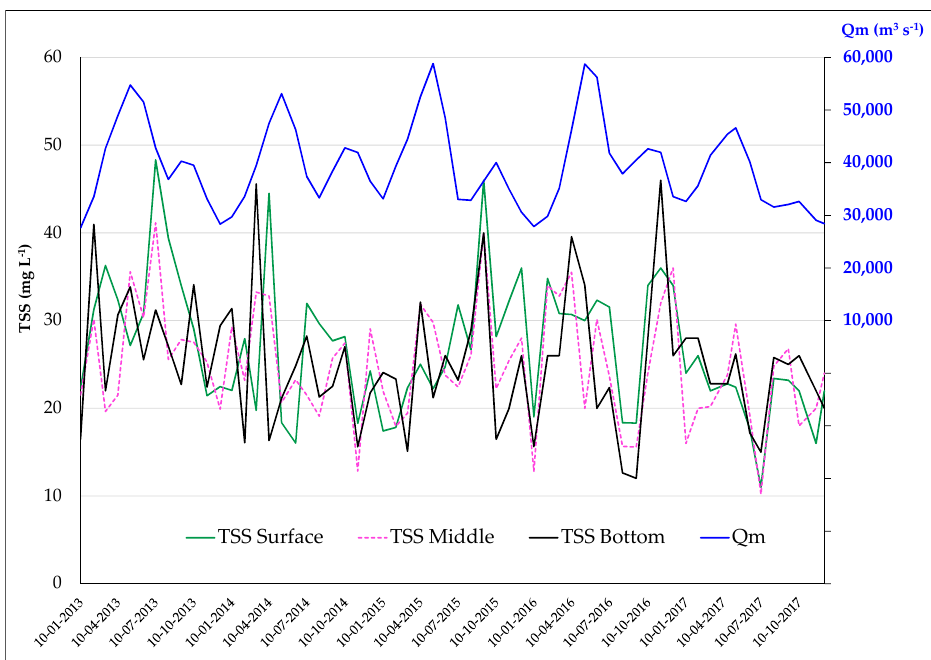
Figure 11. Temporal evolution of TSS sampled at different depths versus the hydrological cycle on Congo River at BZV/KIN section.